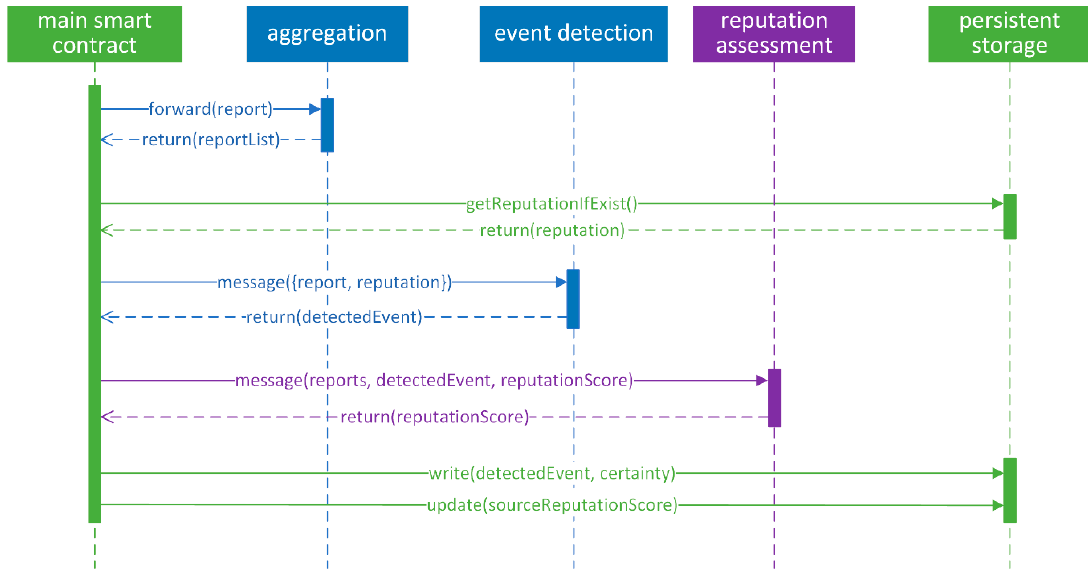
Figure 6. Interactions between smart contracts and persistent storage accessed by main SC.